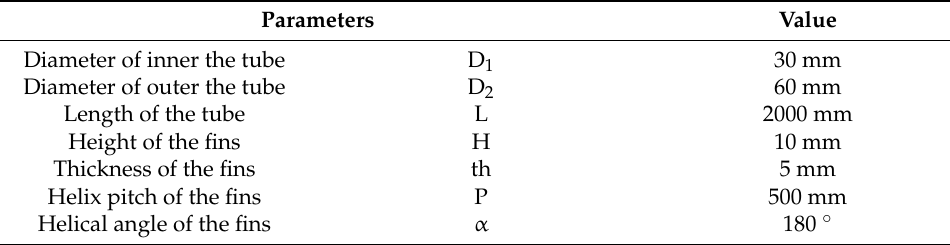
Table 2. Physical parameters of the analyzed collector. Parameters Value Diameter of inner the tube